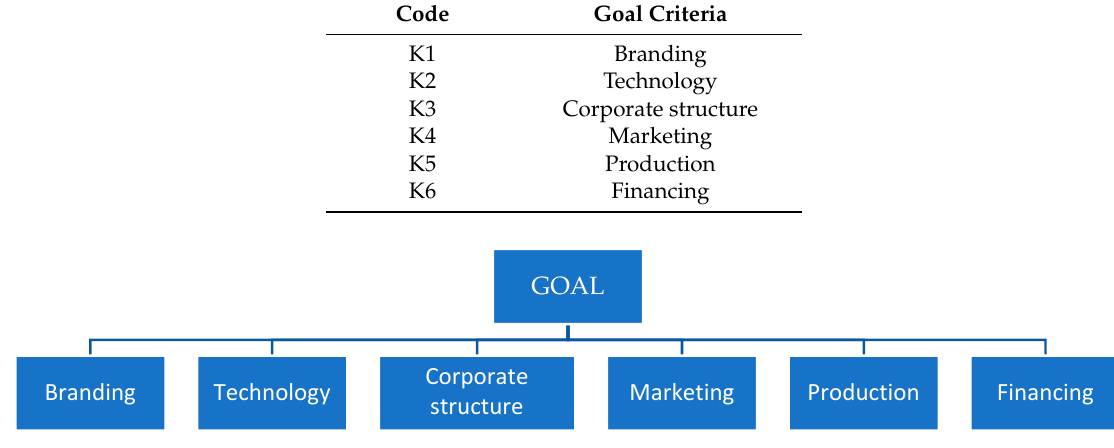
Figure 10. Hierarchical structure.